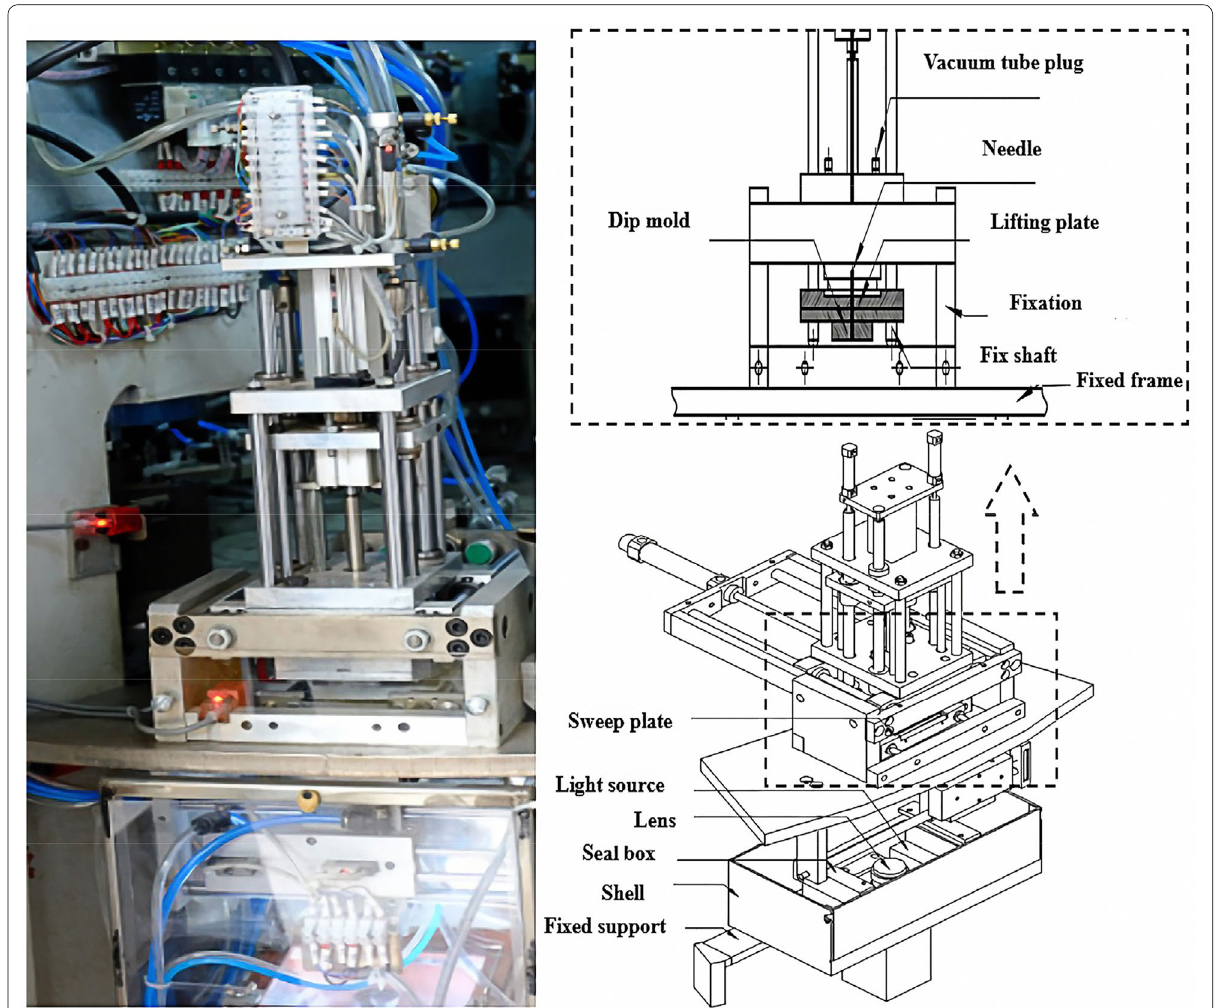
Figure 6 Schematic of station 2 with online inspection system and device for ordered arrangement of diamond